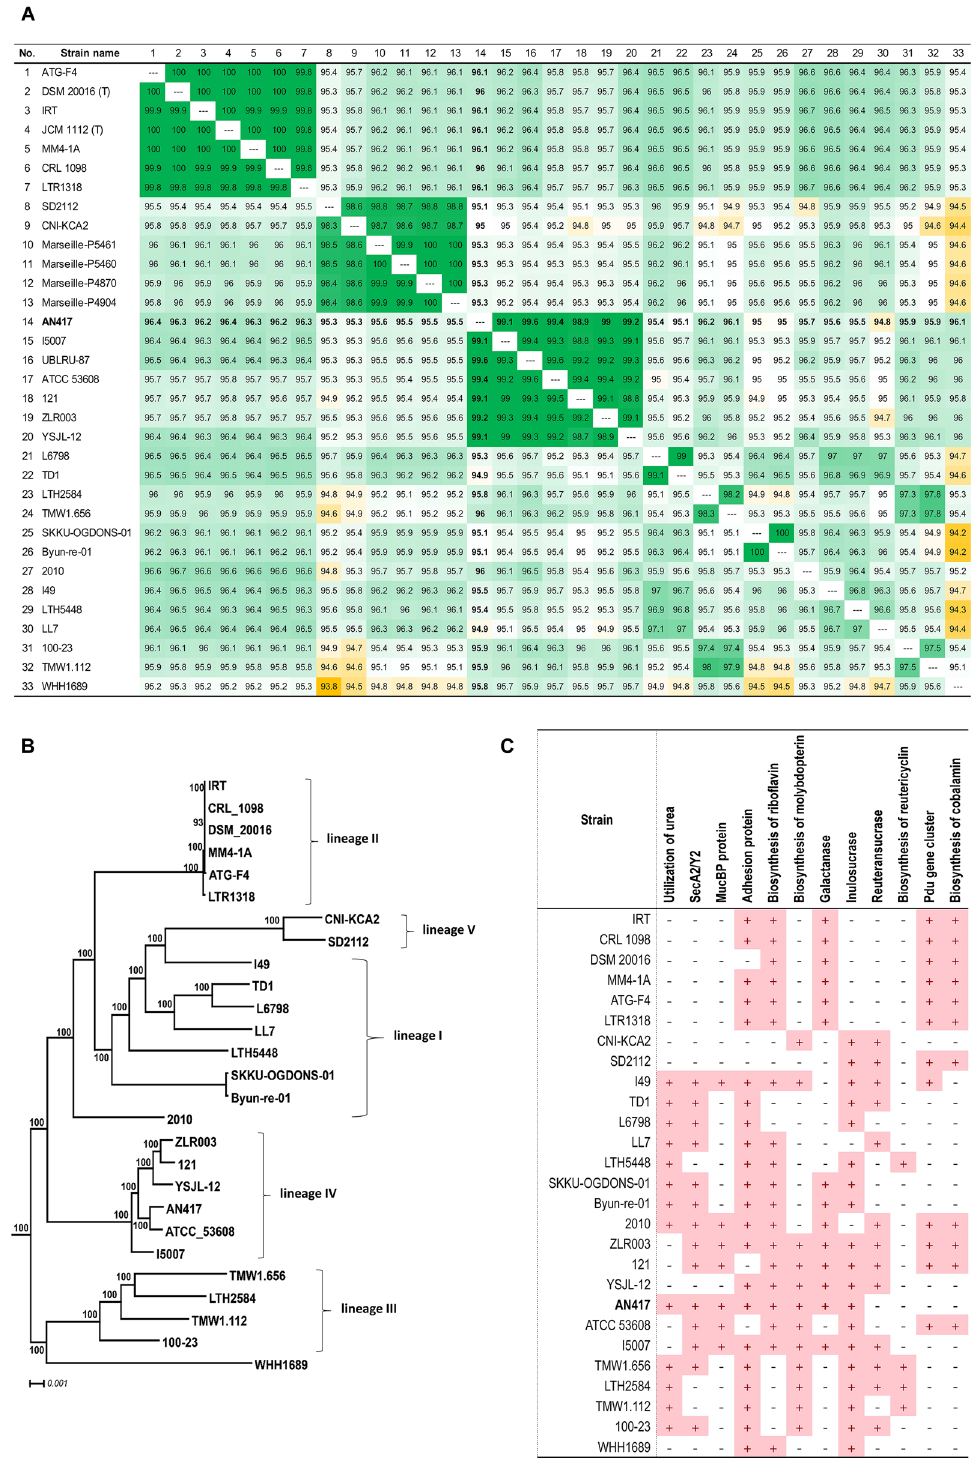
Figure 5. ANI values between genomes of L. reuteri strains and their phylogenetic position. ( A ) ANI values between genomes of L. reuteri strains. ( B ) Phylogenetic tree reconstructed using the amino acid alignments of 766 core genes using the maximum likelihood approach. Numbers above branches show maximum likelihood bootstrap supports from 500 non-parametric replicates. The tree was rooted using L. gastricus LG045 and L. secaliphilus DSM 17896 as outgroups. The scale bar represents the number of substitutions per site. ( C ) Genes encoding proteins related to environmental adaptation and antimicrobial